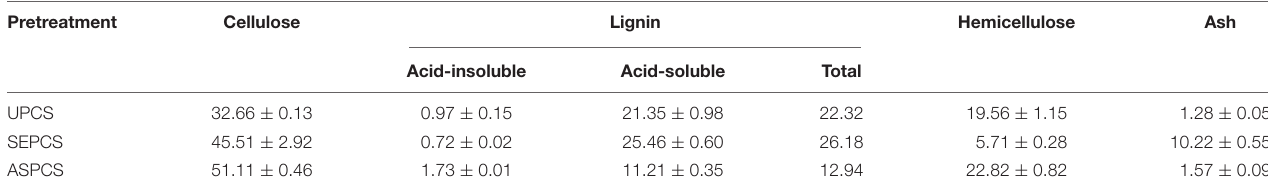
TABLE 1 | Chemical compositions of corn stover samples with/without pretreatment (% W/W).